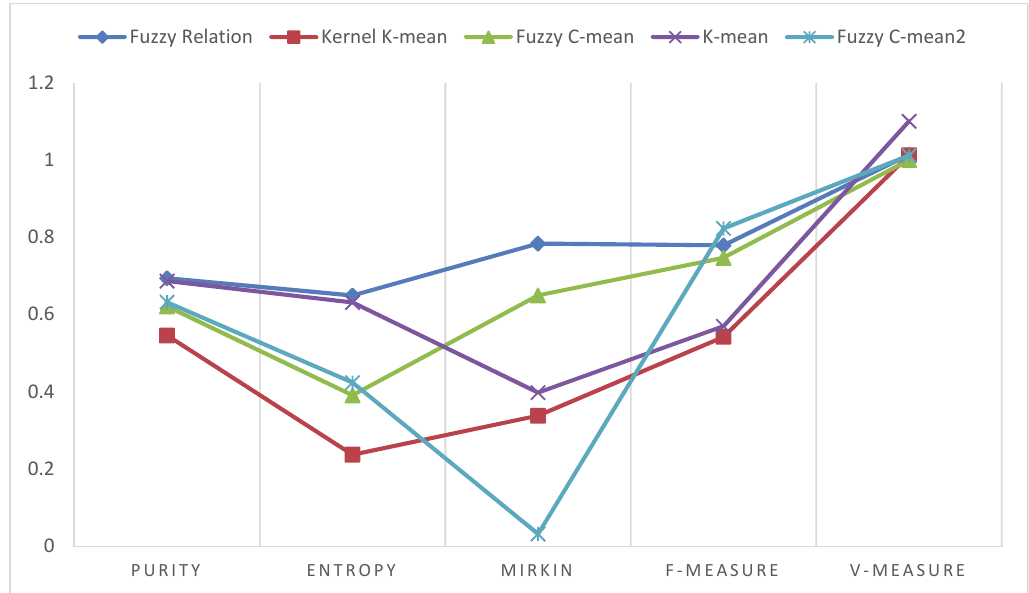
Fig. 2 . Average values of the validity indices for Clustering Algorithms